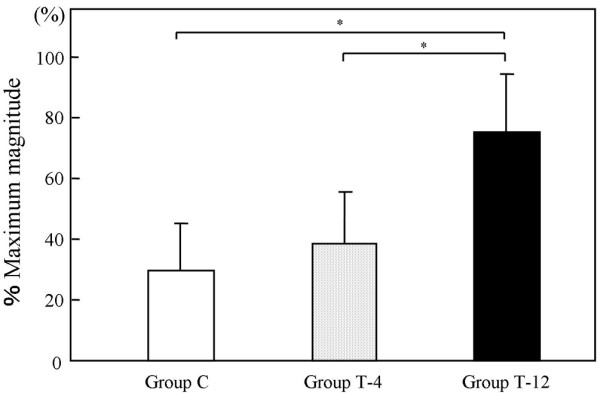
Bar graph representing ultrasonic findings in rabbits with cartilage defects treated with cell/scaffold implants. Group C, control defect group; Group T-4, tissue-engineered-cartilage group at 4 weeks after implantation; Group T-12, tissue-engineered-cartilage group at 12 weeks after implantation. The error bars represent the standard deviation of each group. The percentage maximum magnitude is expressed as the maximum magnitude of the measurement area in the operated knee, divided by that of the intact cartilage of the opposite, nonoperated knee. *P < 0.05 on the nonparametric Mann–Whitney U test.